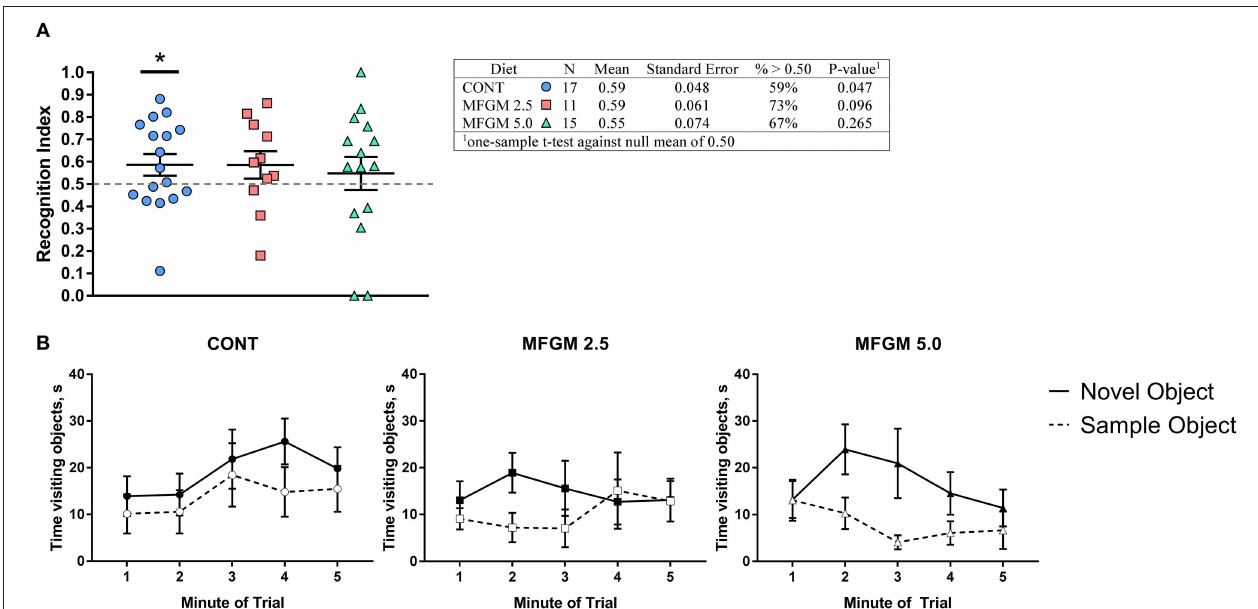
FIGURE 4 | (A) Recognition index across the duration of the trial and (B) binned by minute. Overall, performance between groups was similar, however only the control group was able to demonstrate a recognition index. Despite having the same average as the CONT group, the MFGM-2.5 group had greater variance, and thus, was not different from a chance value of 0.5. As the plots in (B) demonstrate, all groups showed a preference for the novel object at some point during the trial, however both groups fed MFGM demonstrating a null preference at the beginning and end of each trial. CONT, control; MFGM, milk fat globule